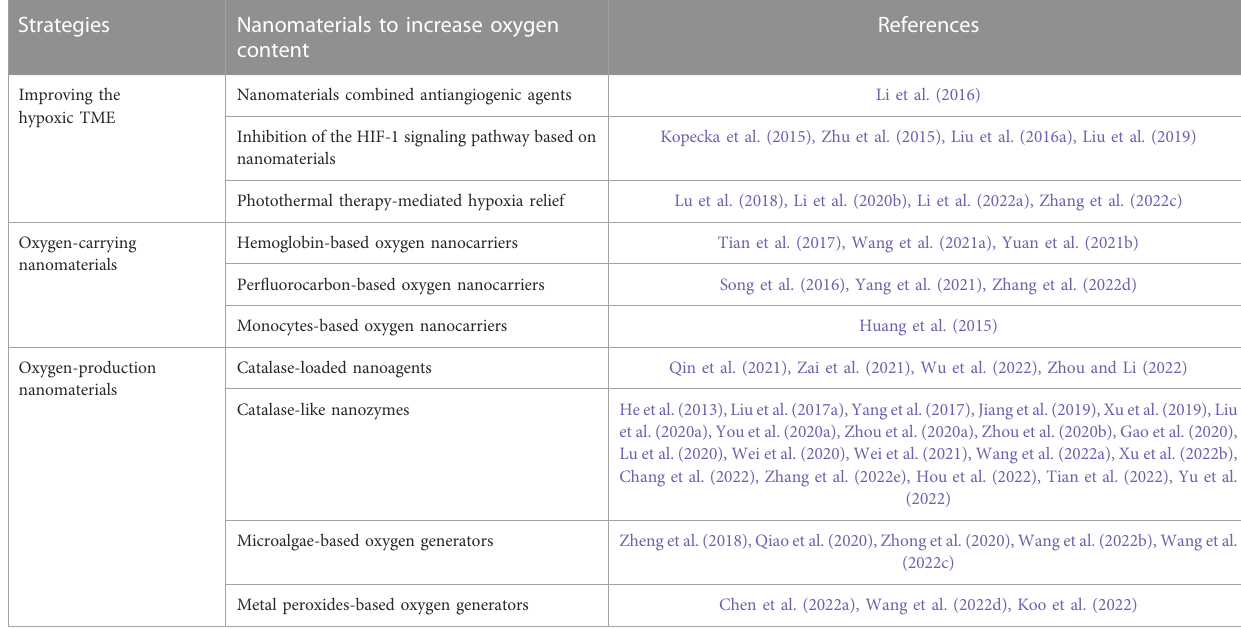
TABLE 1 Nanotechnological strategies to increase the oxygen content of tumors.